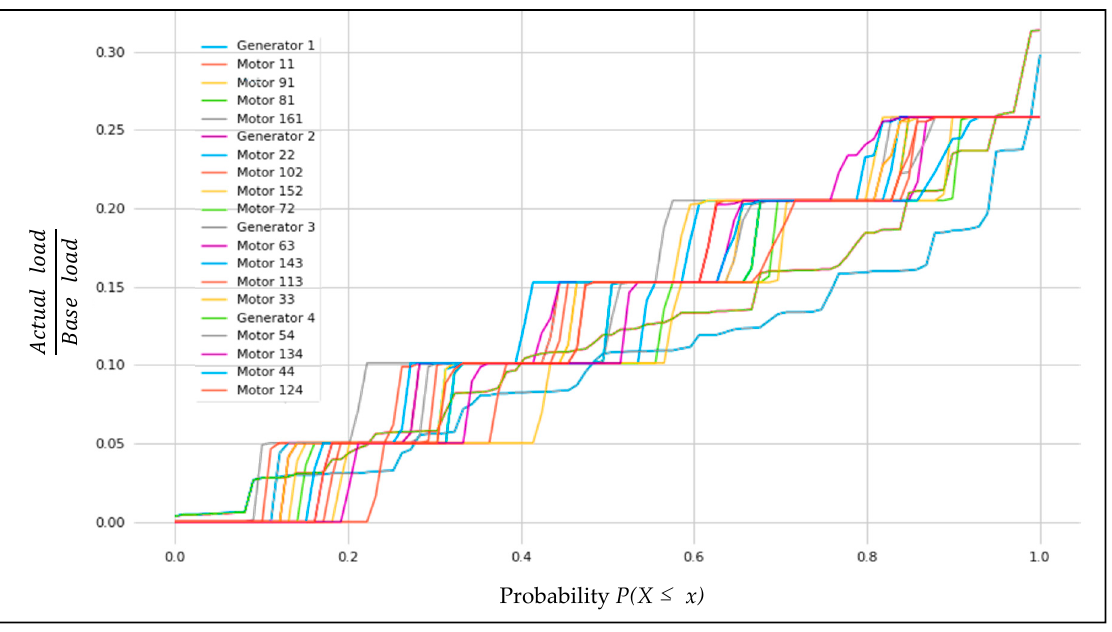
Figure 29. LH TO branch load probability.